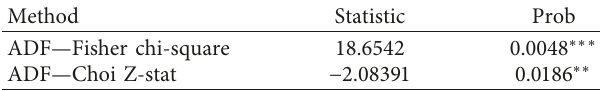
Table 6: Test result of the panel unit root test.